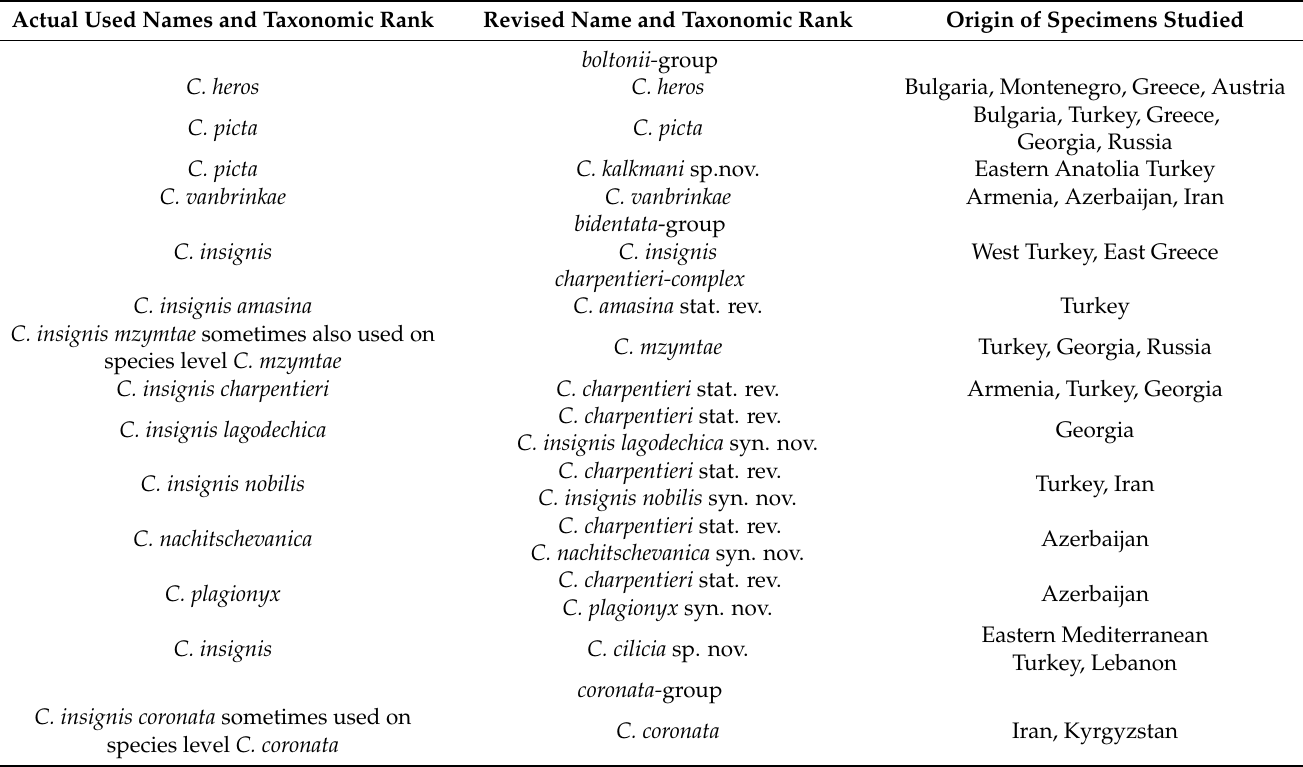
Table 2. (Overview Table): Actual used names and taxonomic rank as well as revised names and taxonomic rank, and the country of origin of the Cordulegaster specimens investigated.